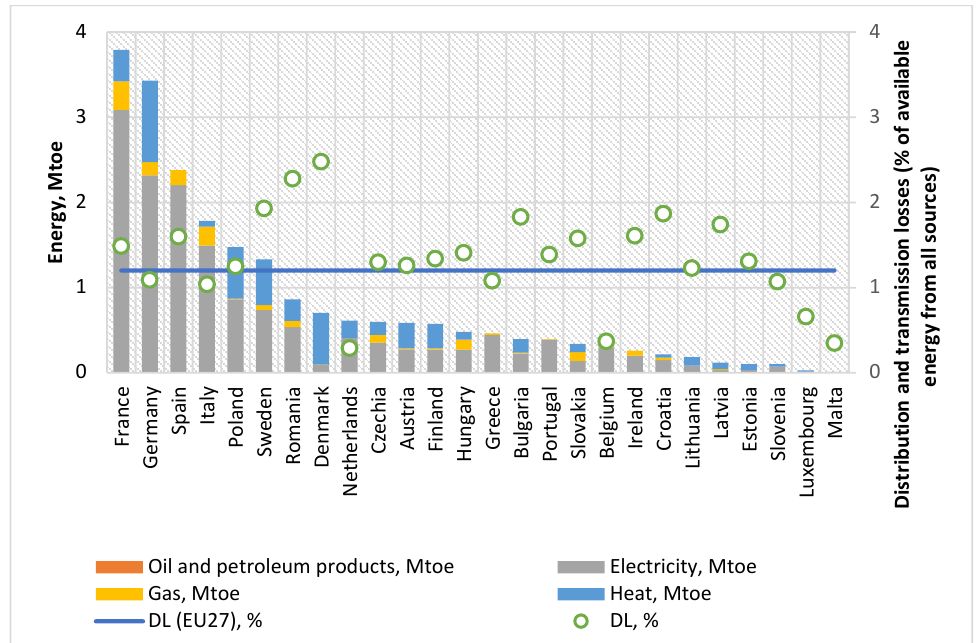
Figure 5. Distribution and transmission losses, 2020 (based on the Eurostat’s data (ec.europa.eu/eurostat/, accessed on 17 August 2022); © European Union, 1995–2022).